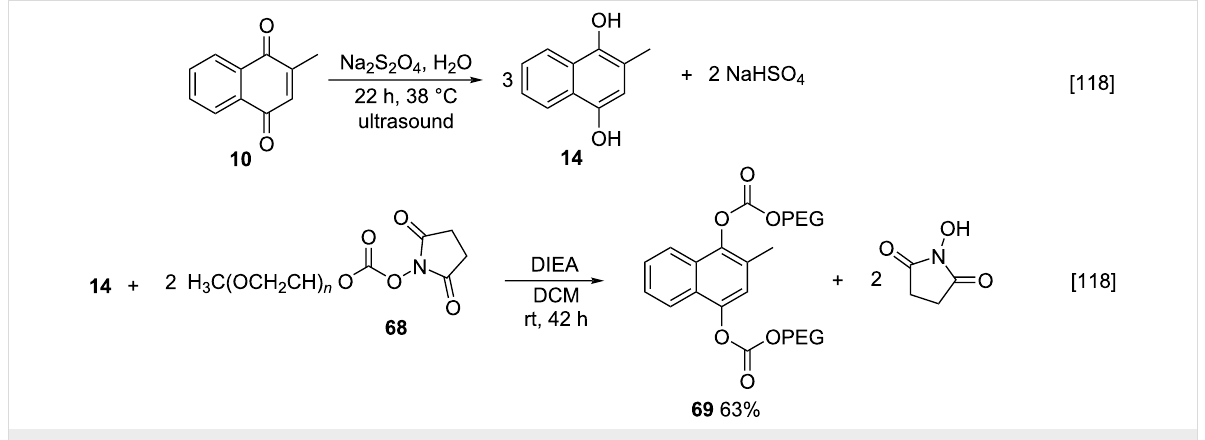
Scheme 20: Green methodology for menadiol synthesis and